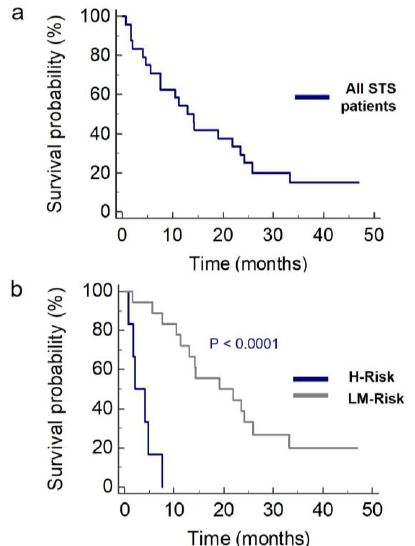
Figure 3. Kaplan – Meier survival analysis for overall survival in all patients with metastatic STS ( a ), and in the high-risk (H-R, n = 6) and low- to medium-risk (LM-R, n = 18) group identified according to their risk score ( b ). Median survival was 2.1 months (95 % CI, 0.8 – 7.6) and 19.1 months (95% CI, 11.3 – 25.8), respectively.